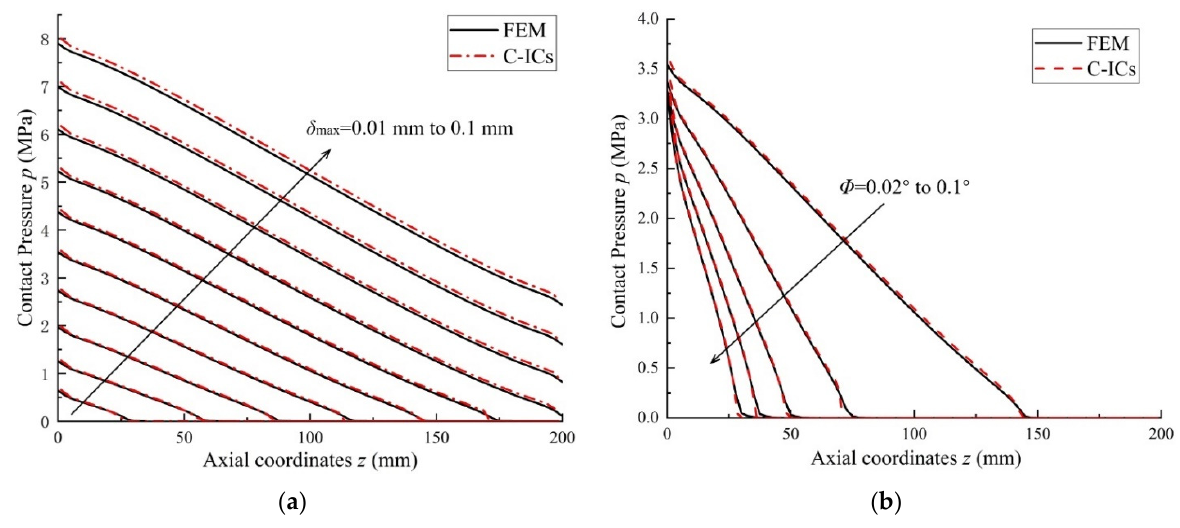
Figure 11. Comparison of axial contact pressure: ( a ) the approachment δ max changed from 0.01 mm to 0.1 mm; ( b ) the inclination Φ changed from 0.02° to 0.1°.